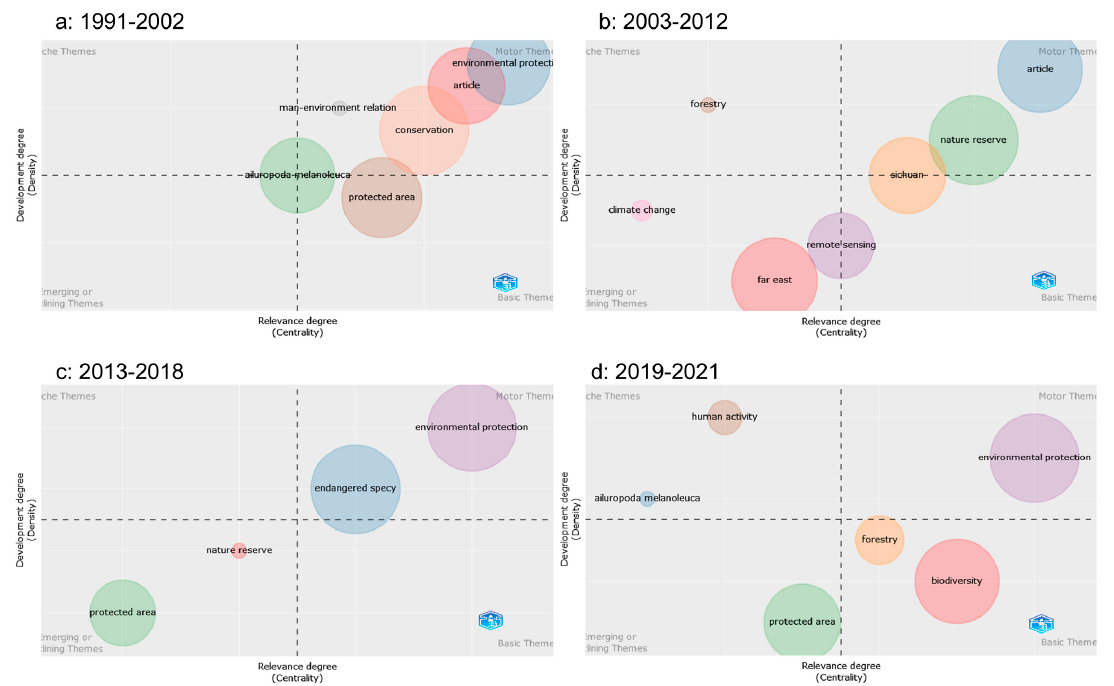
Figure 8. Strategic diagrams of the CPAP-related publications in 1991–2002 ( a ), 2003–2012 ( b ), 2013– 2018 ( c ), and 2019–2021 ( d ). The upper-right quadrant represents motor themes; the upper-left quad- rant indicates isolated themes; the lower-left quadrant showcases emerging or declining themes; the lower right quadrant involves fundamental themes. Each circle represents a topic, and the words